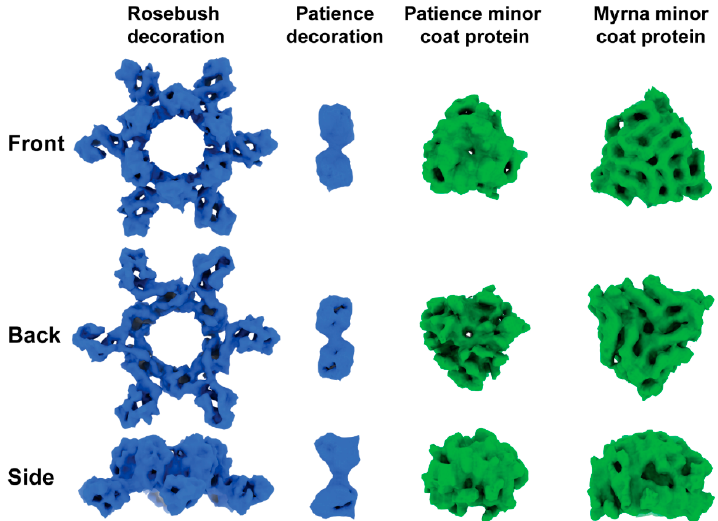
Figure 5. Density of segmented auxiliary proteins. Decoration proteins and minor protein density segmented from capsid maps using the Segger [29] setting in Chimera [27]. Front view is from the outside of the capsid looking in. Back view is from the inside of the capsid looking out. Densities have been scaled relative to one another and their sizes are comparable.